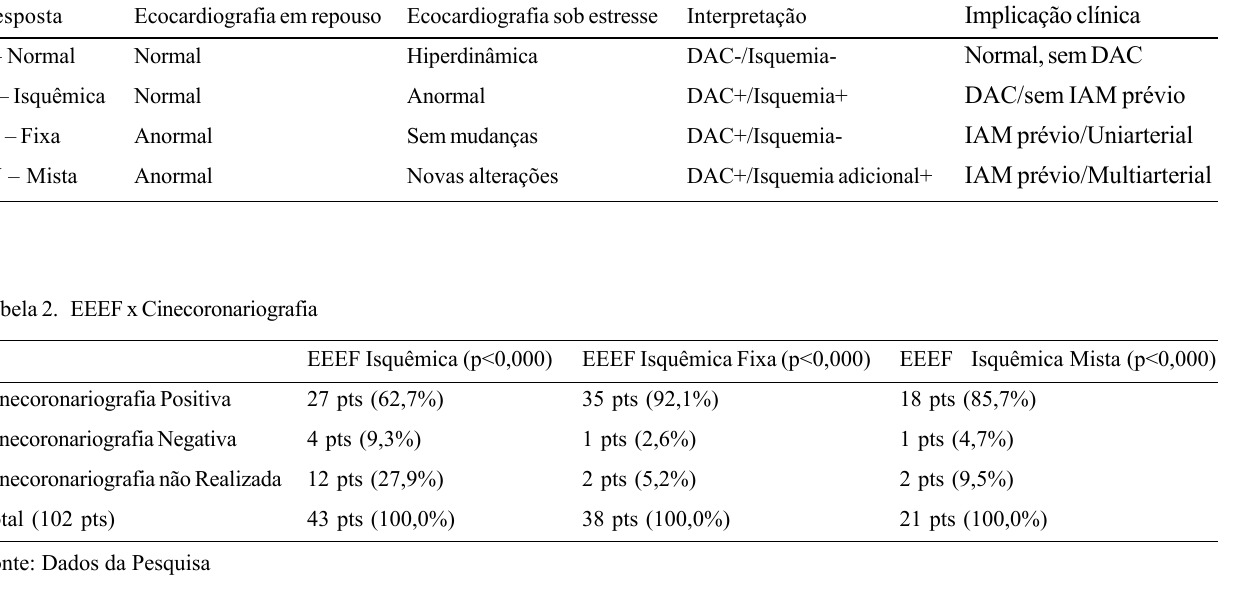
Os resultados demonstraram exames normais em 183 (64,2%) pts, isquêmico em 43 (15,1%) pts, isquêmico fixo em 38 (13,3%) pts e isquêmico misto em 21 (7,4%) pts. Comparando-se com as cinecoronariografias realizadas, a EEF